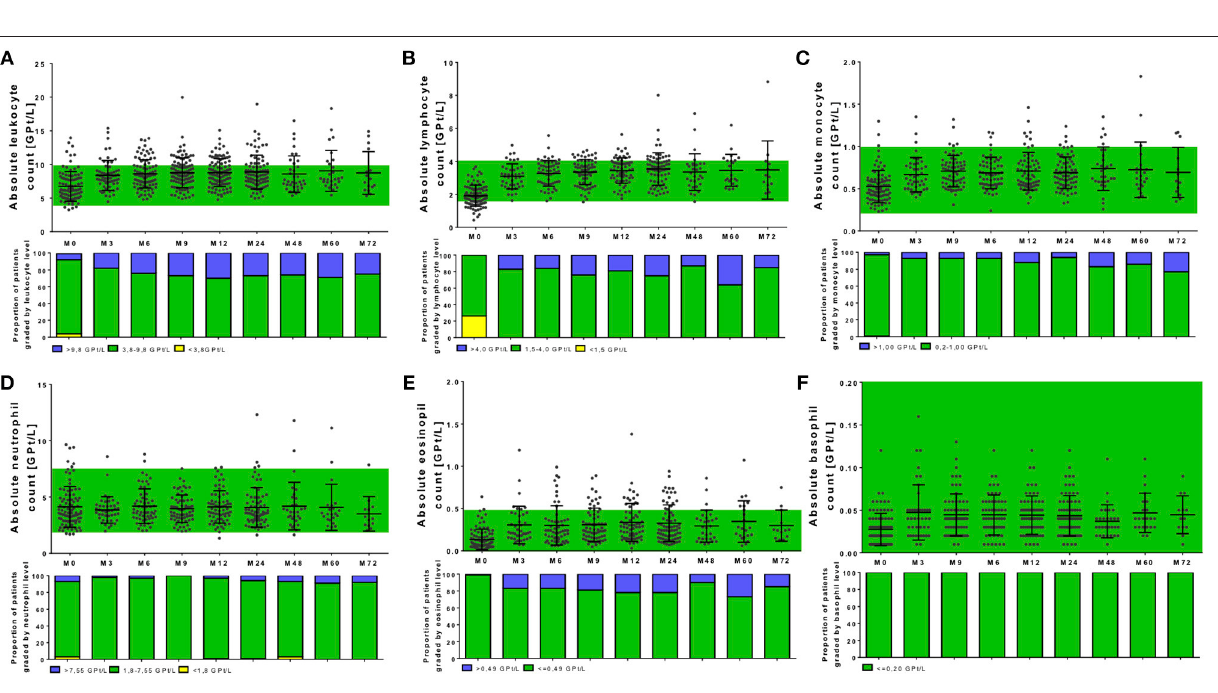
our cohort. At NAT start, 24 patients presented with lymphocyte counts < 1.5 GPT/L without a specific pretreatment